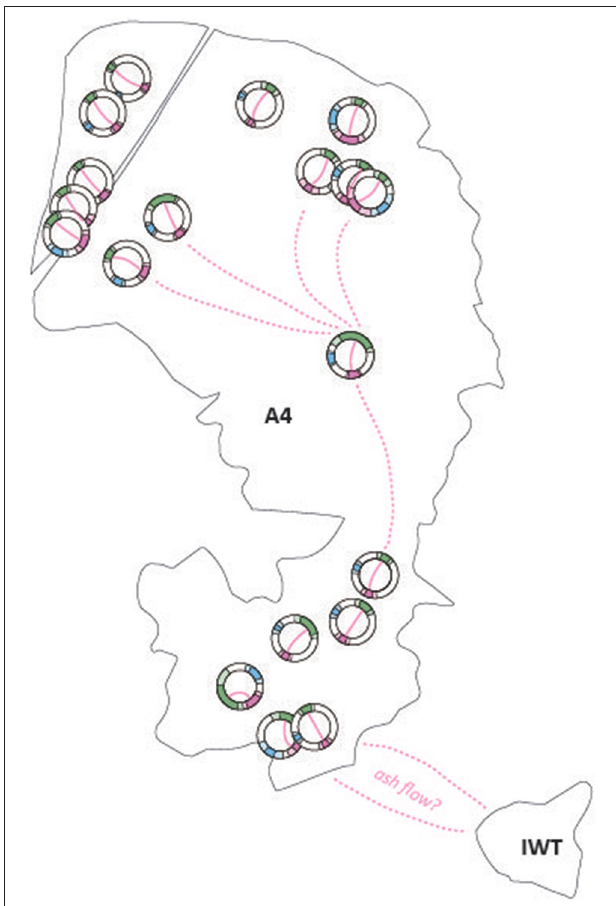
FIGURE 9 | For each site, flow azimuth of ignimbrites was graphically expressed by connecting lines between k 1 and k 3 directions in ring plots. Directional confidence of k 1 , k 2 , and k 3 was displayed for the Jelinek method (darker colors) and the site parametric bootstrap analysis (brighter colors). Assuming a single source area, the geometrically most probable source would be close to the vicinity of the